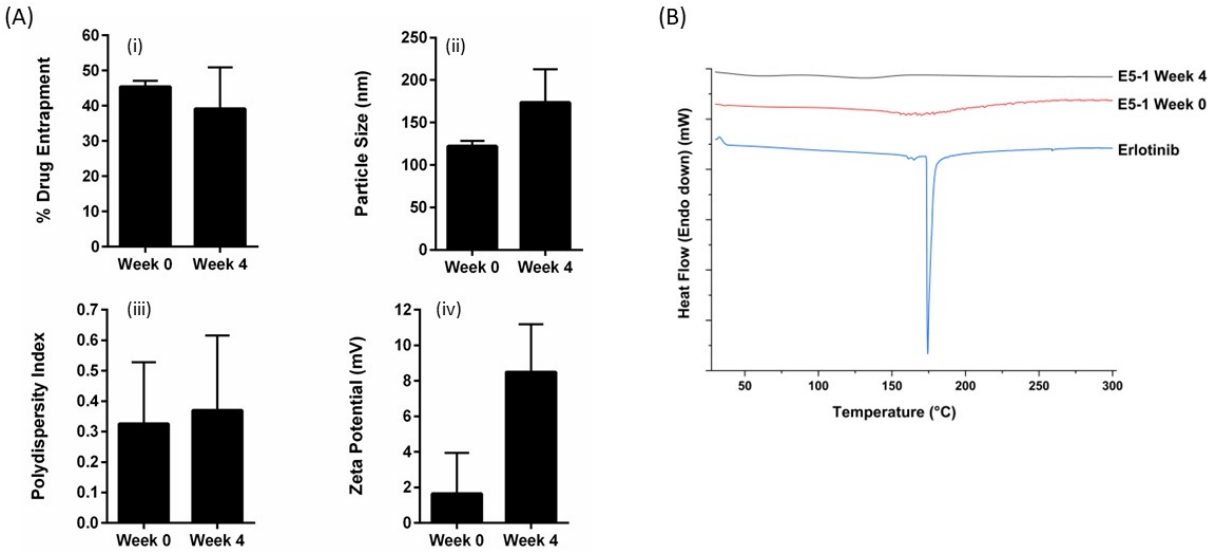
Figure 4. The stability study results for E5-1 nanoemulsion carried out at 40 °C/75% relative humidity over a period of 4 weeks and analyzed for the percentage of drug entrapment (i), particle size (nm) (ii), PDI (iii), zetapotential (mV) (iv) ( A ), and solid-state characteristics using differential scanning calorimeter (DSC) ( B ). Data represent mean ± SD (n = 3).